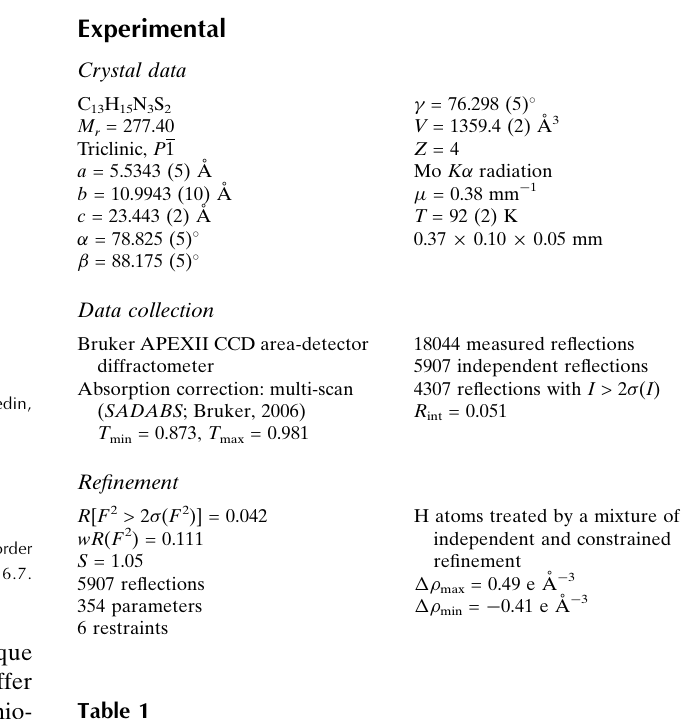
Hydrogen-bond geometry (A˚ , (cid:1)